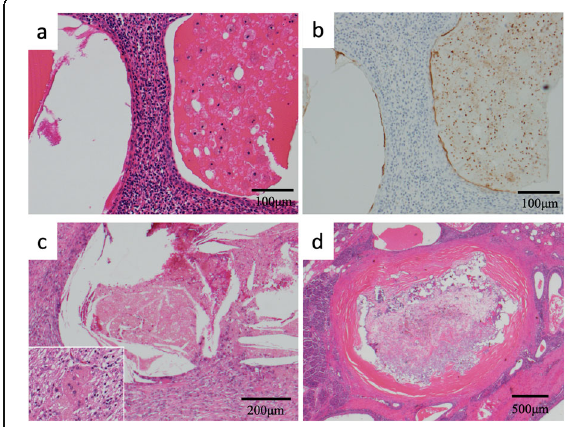
Fig. 5 Histological findings of the cysts in the lesion. a Hematoxylin- eosin (HE) staining. Most cystic walls are lined by stratified squamous epithelium. b Immunopositivity for CA 19-9 is observed in the epithelial cells liming the cyst and in the cystic fluid. c HE staining. The cystic wall has lost stratified squamous epithelium. Mucin in the cyst contains cholesterol clefts. Inset: Foreign-body giant cells and fibroblasts are observed near the cystic wall. d HE staining showing the complete loss of epithelial cells. The cyst contains organized mucin inside, with a thick, hyalinized mucin